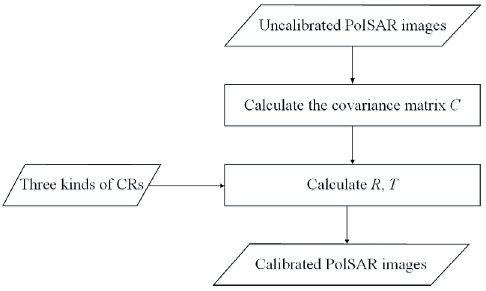
Figure 2 . Flow chart of the Whitt method.